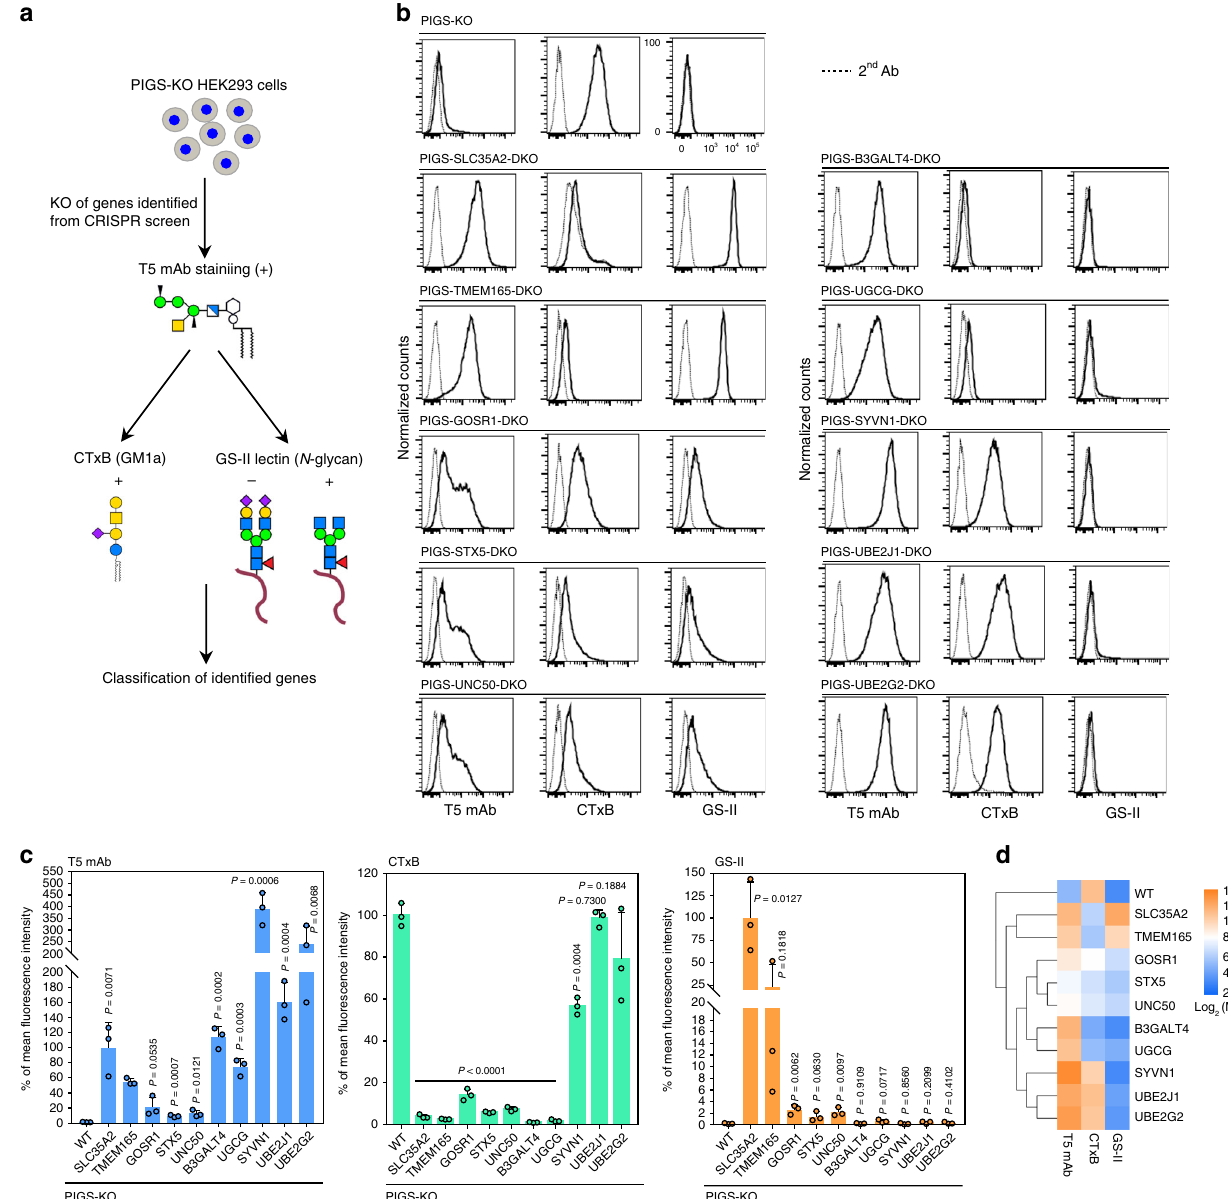
Fig. 2 Validation and phenotypic grouping of CRISPR screen hits. a Schematic depicting validation of the CRISPR screen by further KO of individual genes and stained by T5 mAb, Cholera enterotoxin subunit B (CTxB), and GS-II lectin. b Flow cytometry analysis of PIGS-KO HEK293 cells defective in each gene among 10 top-ranking protein-coding genes identi fi ed by our CRISPR screen. Cells were stained with T5 mAb, GS-II lectin and CTxB, respectively. See also Supplementary Fig. 1g – k and Supplementary Data 2 and 3. c Quantitative data of mean fl uorescence intensity (MFI) from three independent experiments (mean ± SD, n = 3) based on stainings of T5 mAb (left), CTxB (middle), and GS-II (right). P values are from t test (unpaired and two-tailed) with comparisons to control (PIGS-KO). d Hierarchical clustering of glycan pro fi les analyzed by fl ow cytometry analyses, showing the effect (log 2 normalized MFI values) by each gene knockout based on staining of three probes. Source data are provided as a Source Data fi